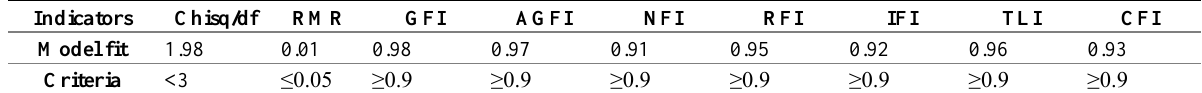
Table 4: Model Goodness of fit